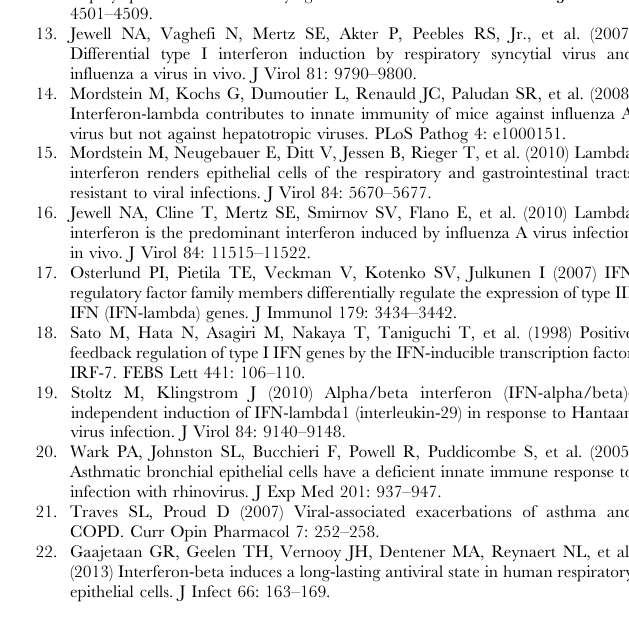
Figure S3 Toxicity of IFNs in A549 cells. A549 cells were exposed to IFN- l 1 (500 ng/ml) or IFN- b (500 IU/ml) for 114 h. determined by MTT assay and compared to each other. Data are represented as mean + / 2 SEM of three independent